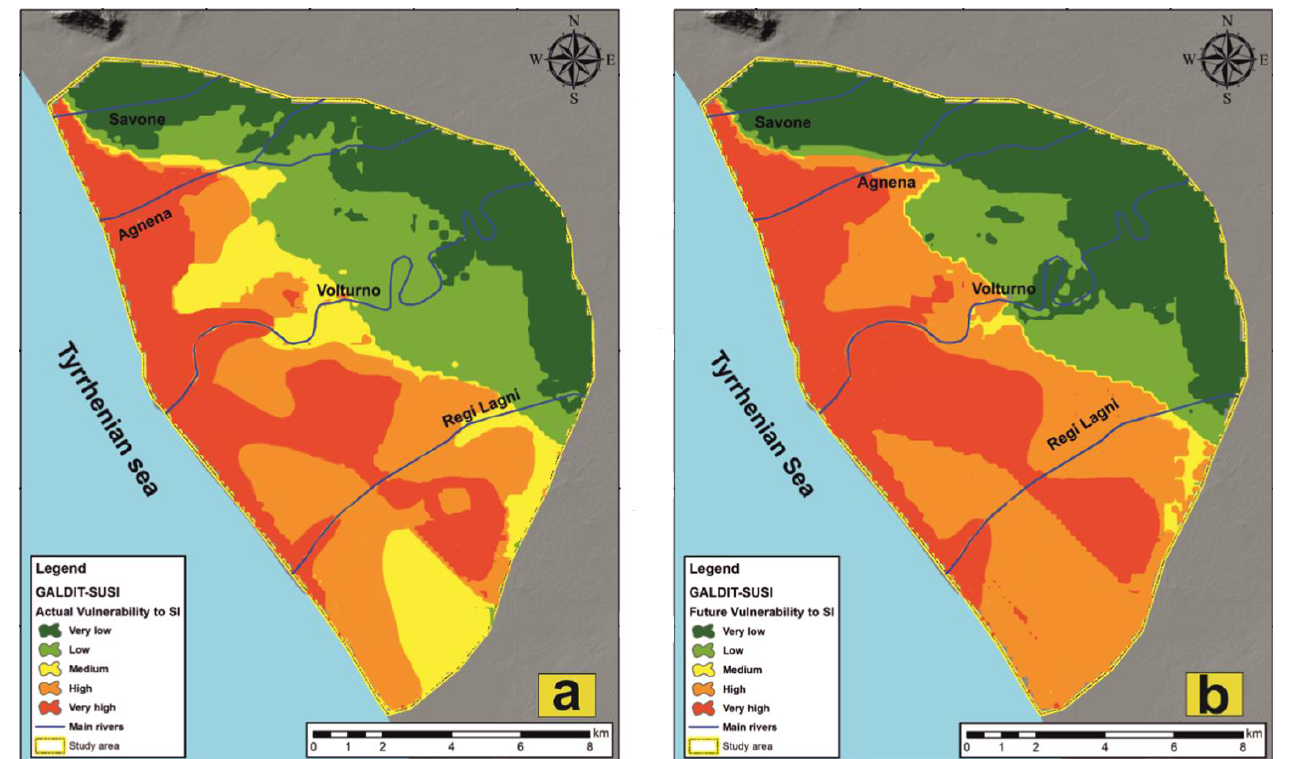
Figure 8. Actual ( a ) and future ( b ) vulnerability to seawater intrusion (SI) calculated according to the GALDIT-SUSI meth- odology.